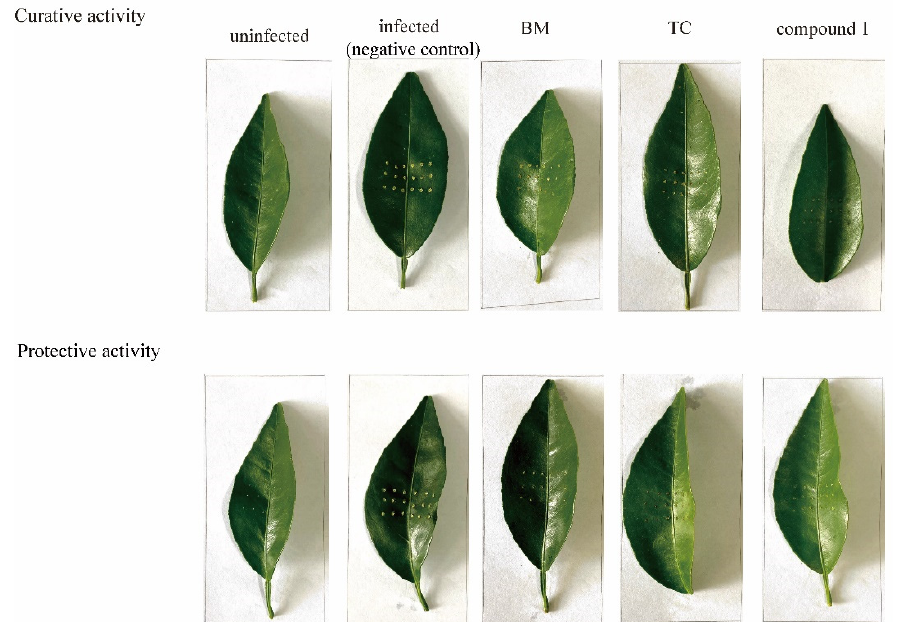
Figure 2. Curative and protective activity of compound 1 against citrus canker in fully expanded young citrus leaves of navel orange; the test concentration was 200 μ g/mL. The sample was placed in a 28 °C constant temperature incubator and absorbent filter paper was used for moisturizing. The spots on the inoculated leaves were observed after 7 days.